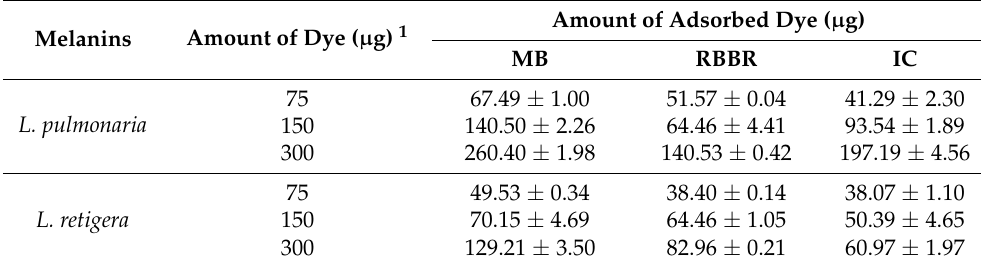
Table 3. The adsorption capacity of melanins from L. pulmonaria and L. retigera .